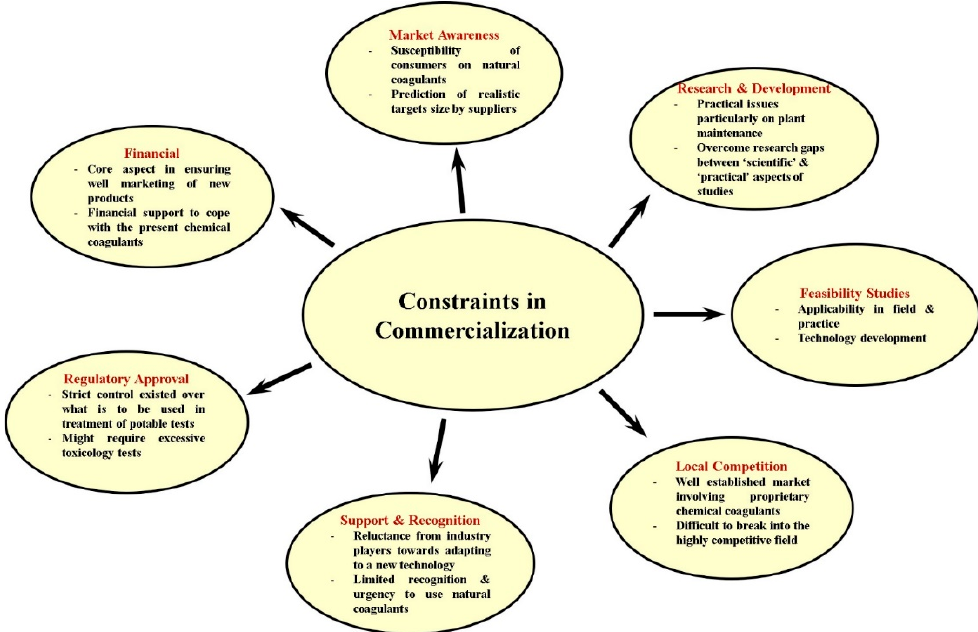
Figure 5. Various constraints in commercialization of natural coagulants.